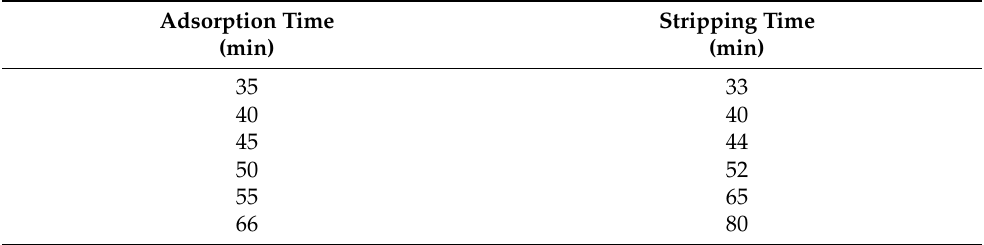
Table 1. The relationship between adsorption and stripping